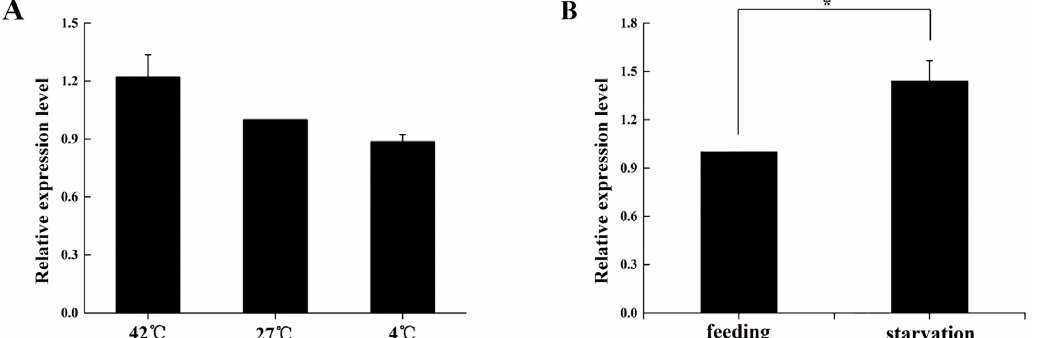
Figure 7. Expression profile of BdOct β R1 when B. dorsalis adults were kept under thermal ( A ) or starvation stress ( B ). The data are means ± S.E. of three independent experiments. Asterisk (*) above indicates a statistical difference determined by the independent samples t -test (* p < 0.05).